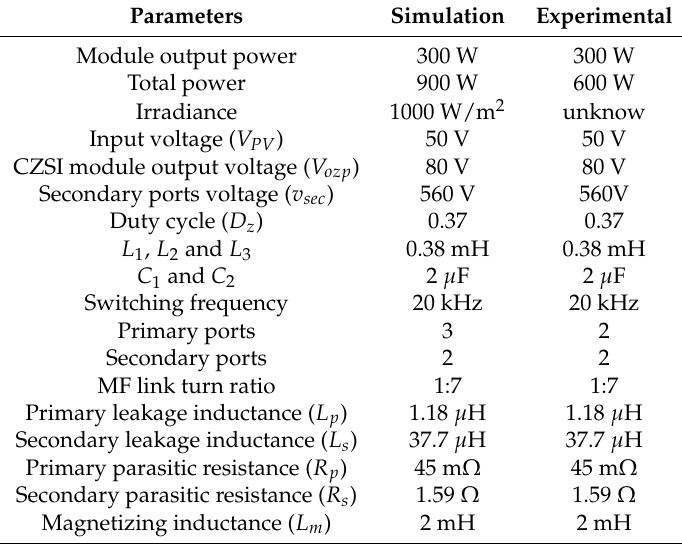
Table 1. Simulation and experimental